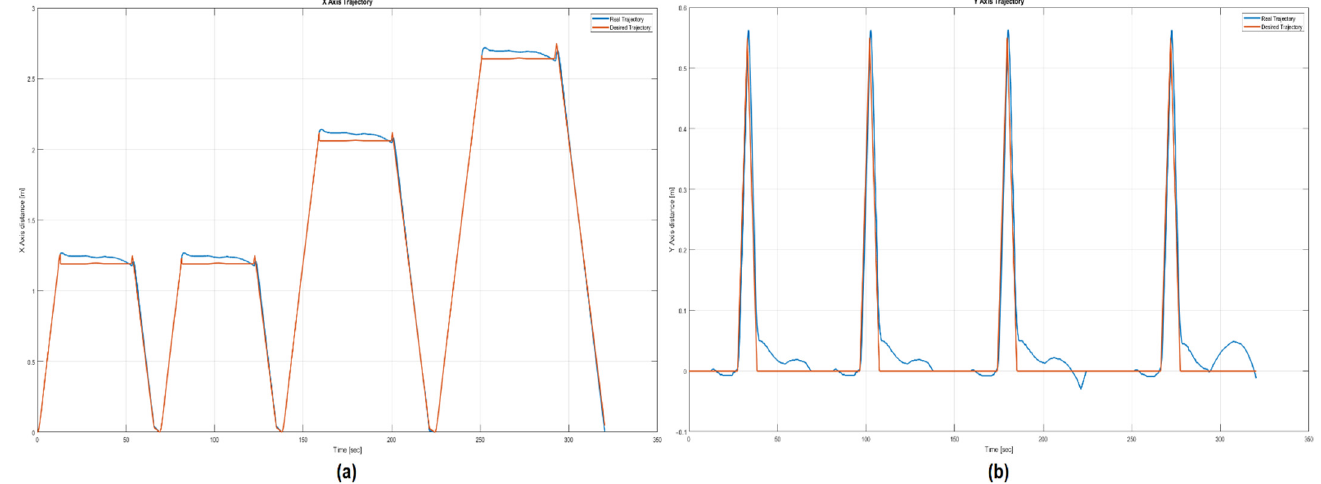
Figure 30. Full disassembly process. Desired and real trajectories of ARS PeopleBot based on TTSMC: ( a ) X axis, ( b ) Y axis.